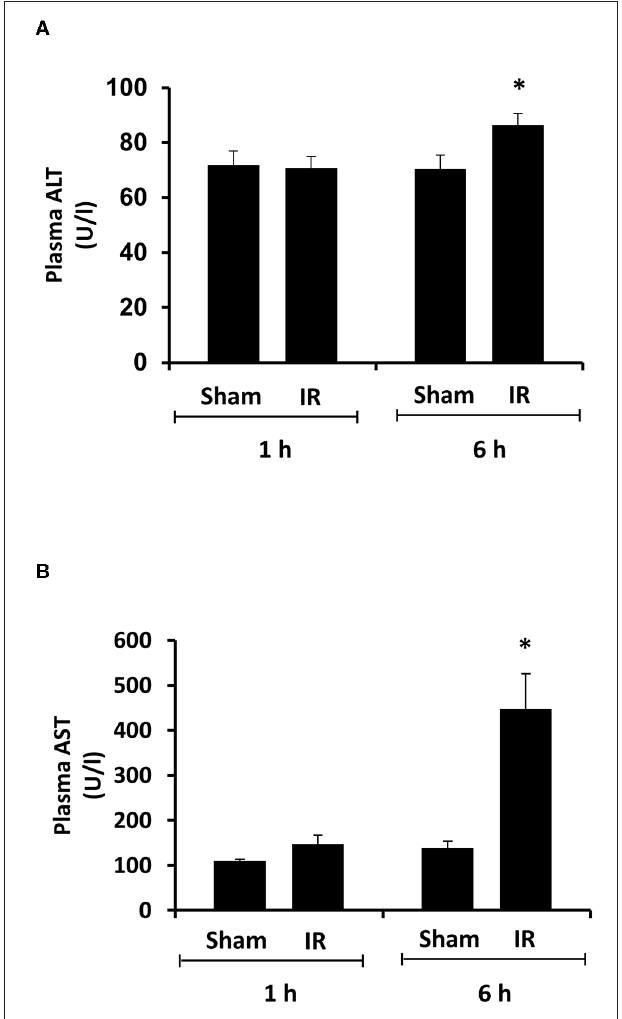
FIGURE 3 | Effect of kidney ischemia-reperfusion on liver function. The left kidney of rats was subjected to 45min ischemia followed by 1 hour (1h) or 6 hours (6h) of reperfusion (IR). As a control, rats were subjected to a sham-operation without inducing ischemia (Sham). Plasma alanine transaminase (ALT) (A) and aspartate aminotransferase (AST) (B) were measured. Results are expressed as mean ± SE ( n = 5 for each group). * p < 0.05 when compared with the value obtained from the sham-operated group.